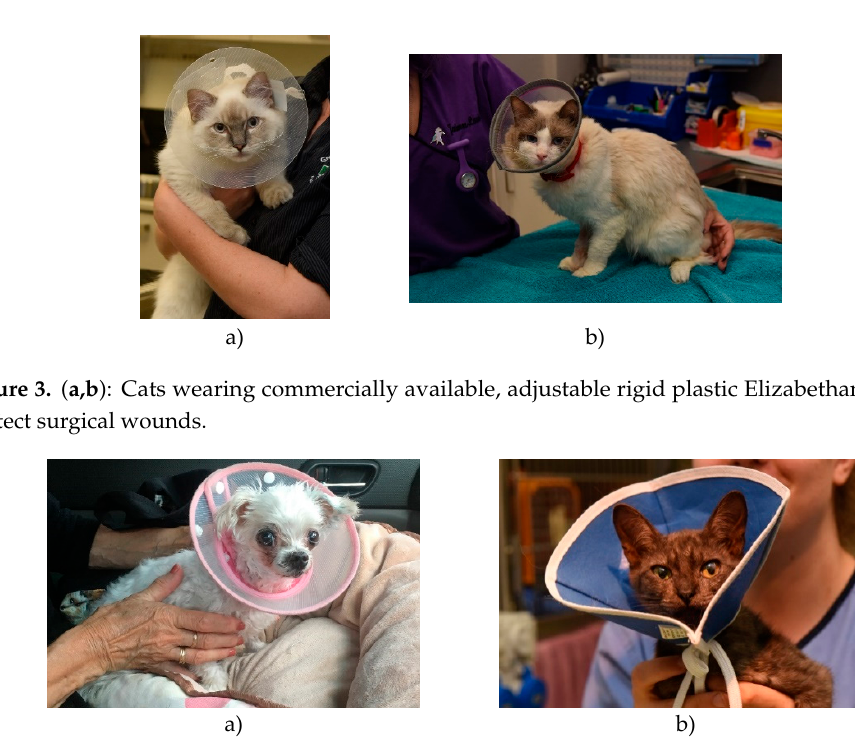
Figure 2. (a)–(c) : Dogs wearing commercially available, adjustable rigid plastic Elizabethan collars to protect surgical wounds.